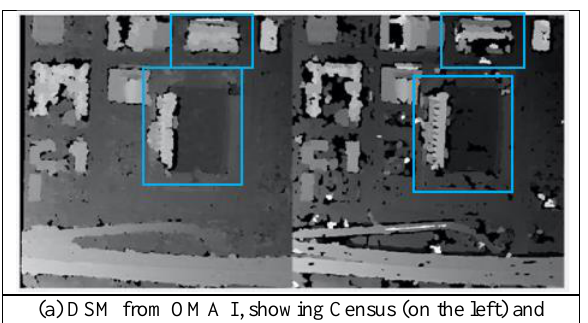
(a) DSM from OMA I, showing Census (on the left) and MC-CNN (on the right)